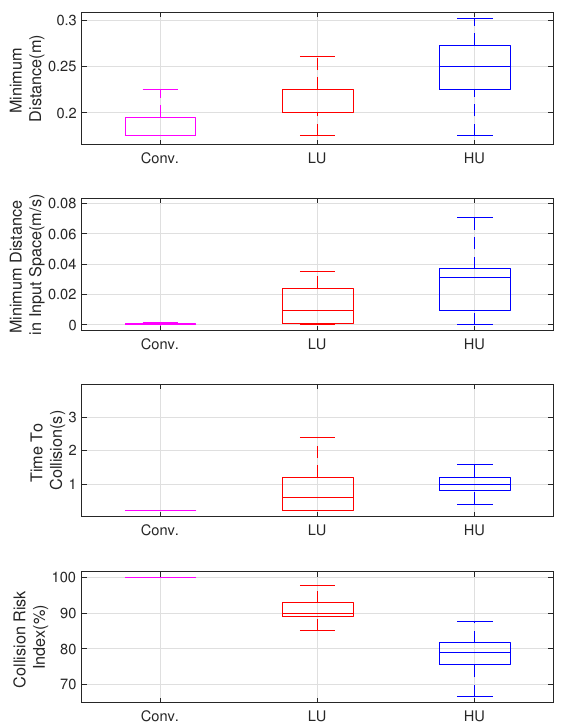
Figure 13. Navigation results: comparison of the safety